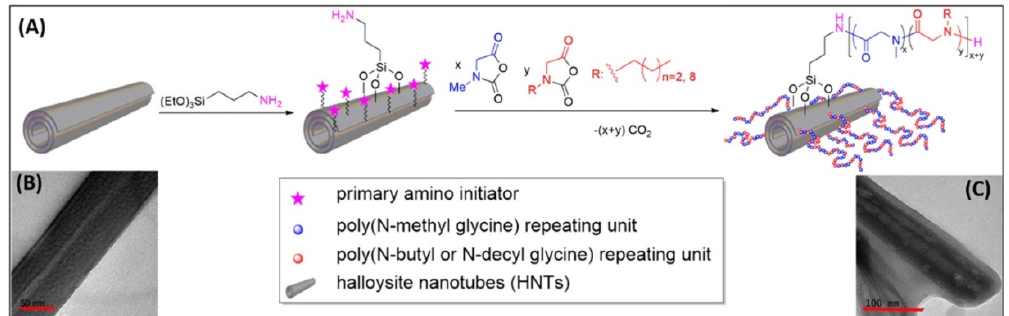
Figure 10. ( A ) Schematics showing the functionalization of HNTs with amphiphilic poly-peptoids by the surface-initiated polymerization method. ( B ) Representative TEM images of p-HNTs and ( C ) M80B20-g-HNTs in the dry state. Reproduced with permission from [125].